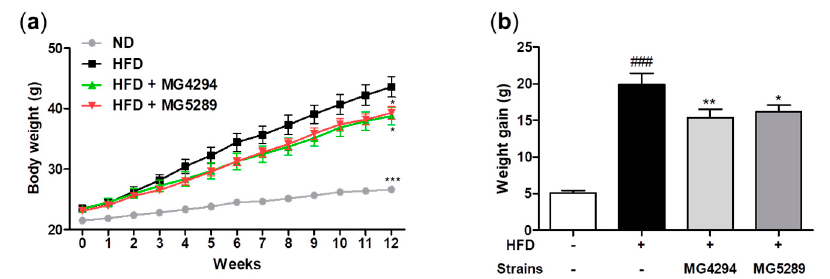
Figure 4. Administration of L. fermentum MG4294 and L. plantarum MG5289 alleviate body weight ( a ) and weight gain ( b ) in HFD mice. The data are expressed as mean ± SEM ( n = 6). ### p < 0.001 compared with ND group; * p < 0.05, ** p < 0.01 and *** p < 0.001 compared with